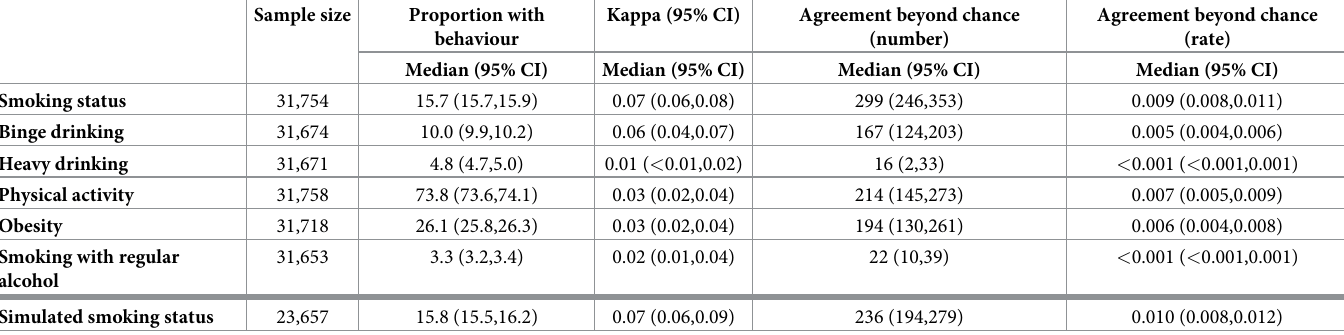
Table 1. Selected statistics describing the agreement between the two donor records across the 100 repetitions of the SEER cancer registry data for each of the six behaviours. Sample